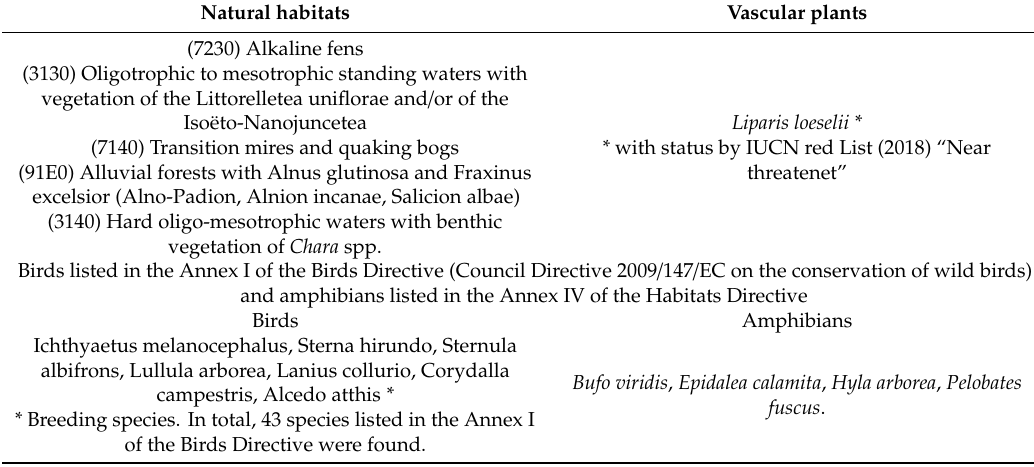
Table 3. Habitats and Species Included in the Annexes of the Habitats Directive and Birds Directive (Council Directive 92 / 43 / EEC on the Conservation of Natural Habitats and of Wild Fauna and Flora), [37,52]